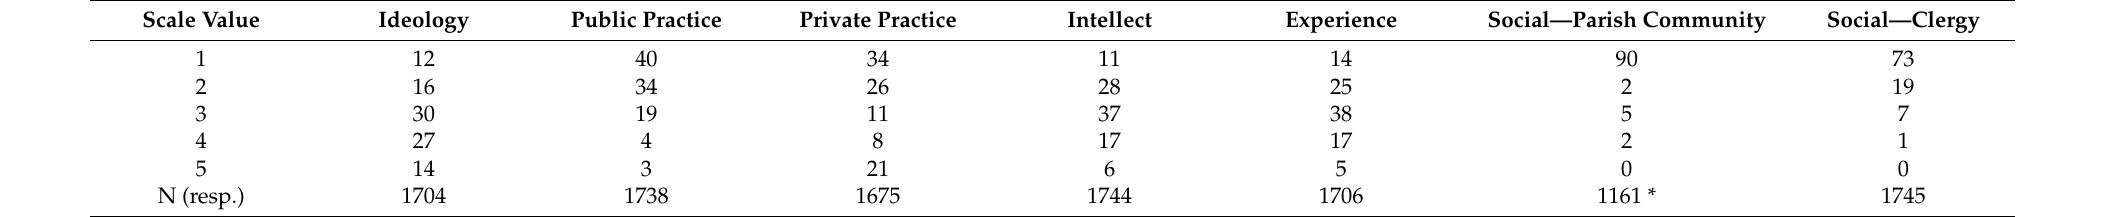
Table 3. Linear distributions of the CRS-SOC items: Online survey—General population sample (column %).